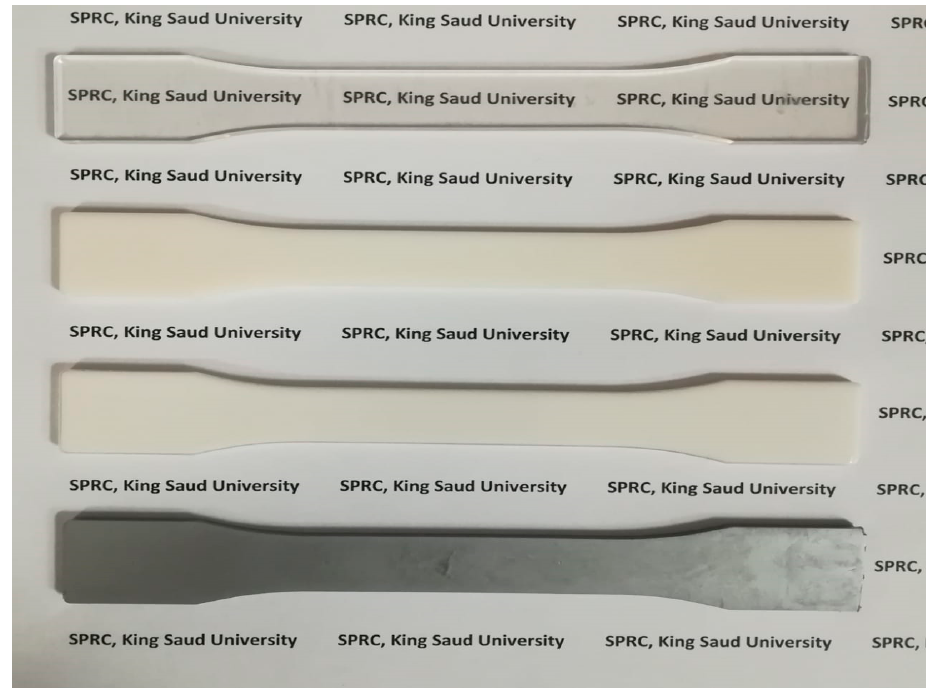
Figure 3. Injection-moulded tensile bar appearance of polymers and composites. From top to bottom: amorphous PET bar is transparent; semi-crystalline PBT bar is white; 60/40 PBT/PET bar is cream tinted; and the Al nano platelet-filled 60/40 PBT/PET bar is silvery.